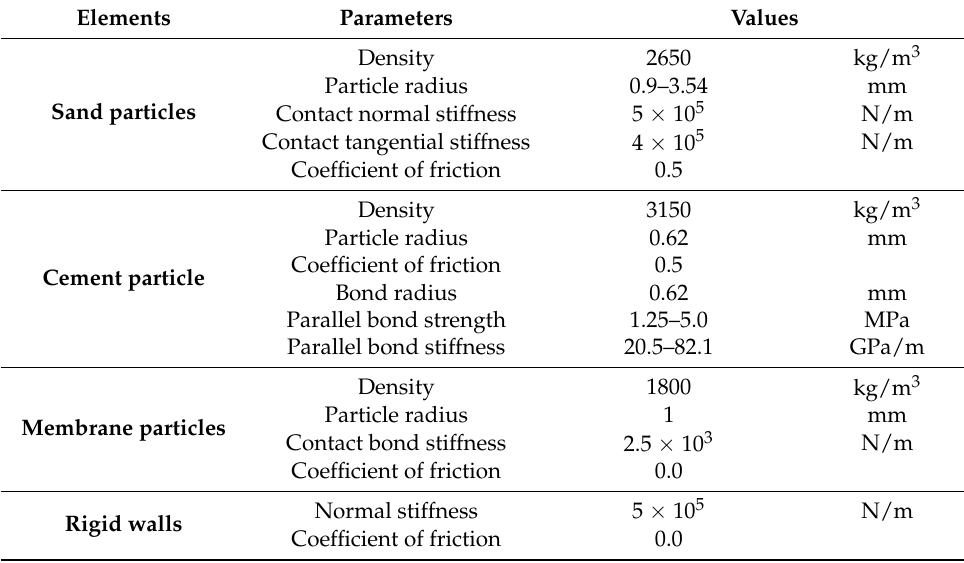
Figure 1. Grain size distribution of sand particles. Table 1. Parameters of three types of particles and rigid wall for all samples.